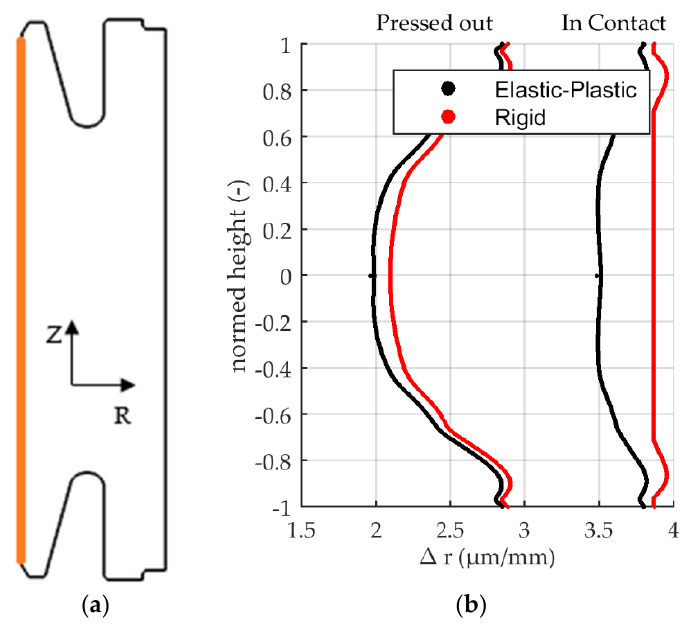
Figure 17. ( a ) Analysis location. ( b ) Relative displacement of the inner radius in µm/mm. Elastic-plastic vs rigid mandrel. Two process steps are shown: (1) Quenched, still in contact with the mandrel. (2) Pressed out after release of elastic energy.